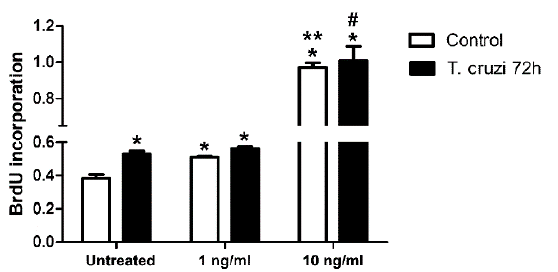
Figure 8. Cardiac fibroblast proliferation treated with TGF- β . Cardiac fibroblasts treated with different concentrations of TGF- β (1 and 10 ng/mL) showed a high proliferation in a dose dependent manner when compared with CF untreated. * p ≤ 0.05 vs. untreated, uninfected control; ** p ≤ 0.05 vs. control + 1 ng/mL TGF- β ; # p ≤ 0.05 vs. T. cruzi 72 h + 1 ng/mL TGF- β . N =3.